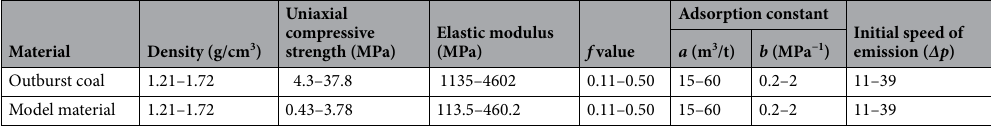
Table 1. Characteristic parameters of outburst coal and model